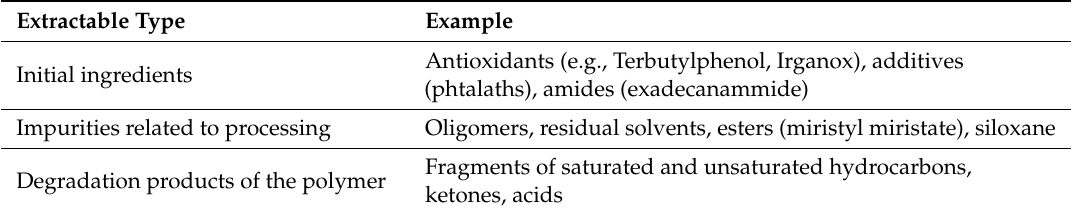
Table 4. Categories of extractable type released from PE